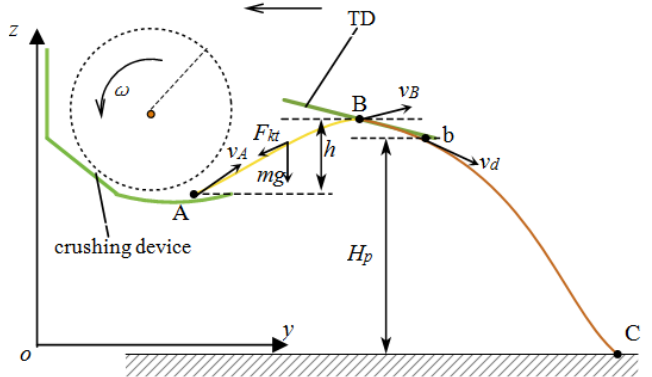
Figure 8. Schematic diagram of straw entering into the throwing device.